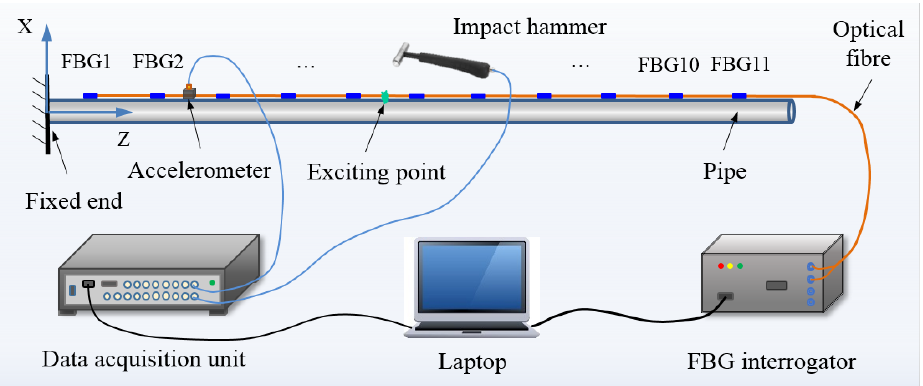
Figure 1. Schematic diagram of experimental setup.